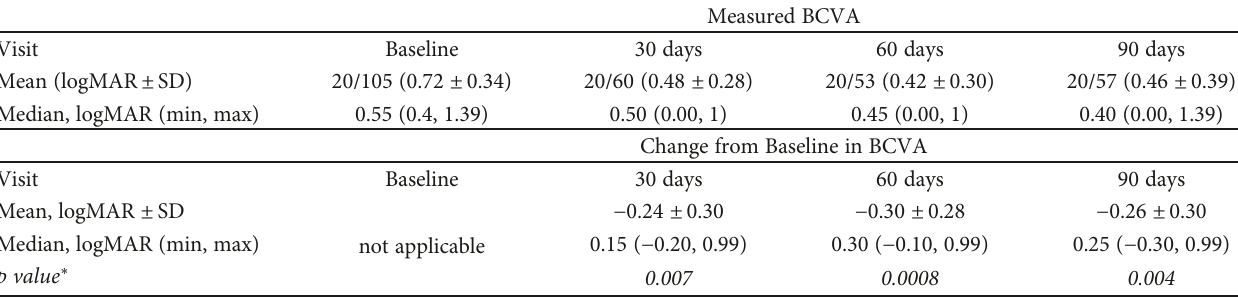
Table 3: Best-corrected visual acuity (BCVA) over time.